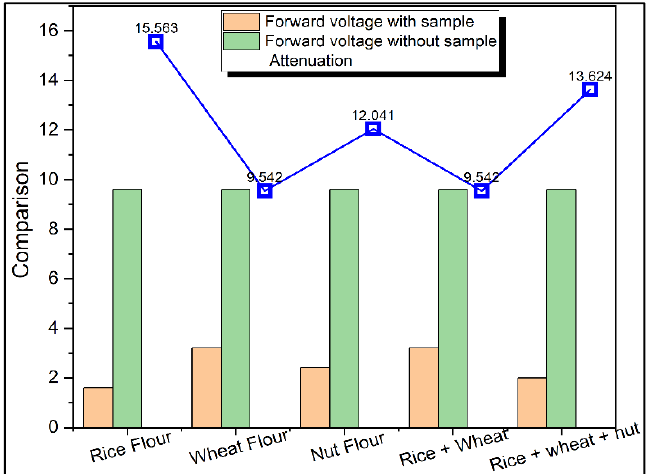
Figure 4. Comparison of input voltage, output voltage and attenuation for rice flour, wheat flour, nut flour and their mixtures.